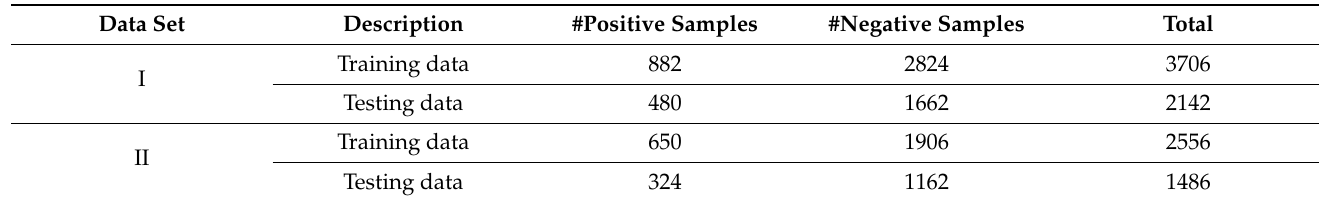
Table 4. Summary of training and testing data for pedestrian classification (#: